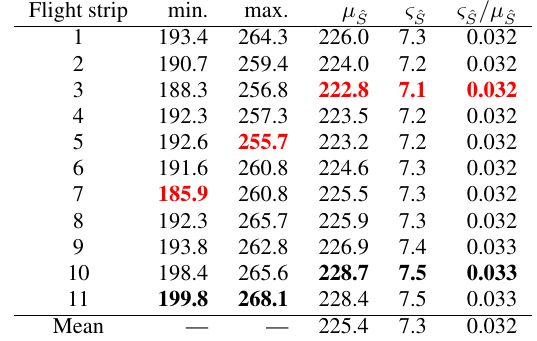
Table 1: Statistics for the system waveform amplitudes ˆ S of the 2004 campaign (unit: DN). Bold figures denote the minima and maxima per category for the whole campaign, resp.